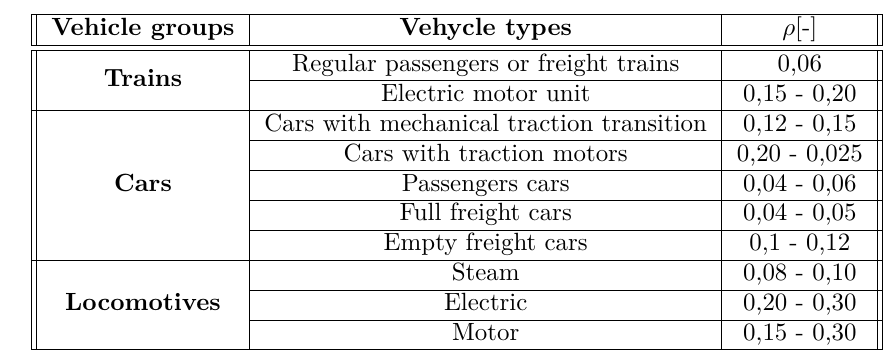
Table 1. Coefficient of rotating parts [2]